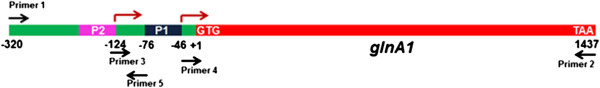
Schematic representation of glnA1 promoter.glnA1 gene with two promoters P1 and P2. +1 represents glnA1 translational start site. The red arrow represents the transcriptional start site. The black arrow represents the position of primers used to make deletion variants of the glnA1 promoter.